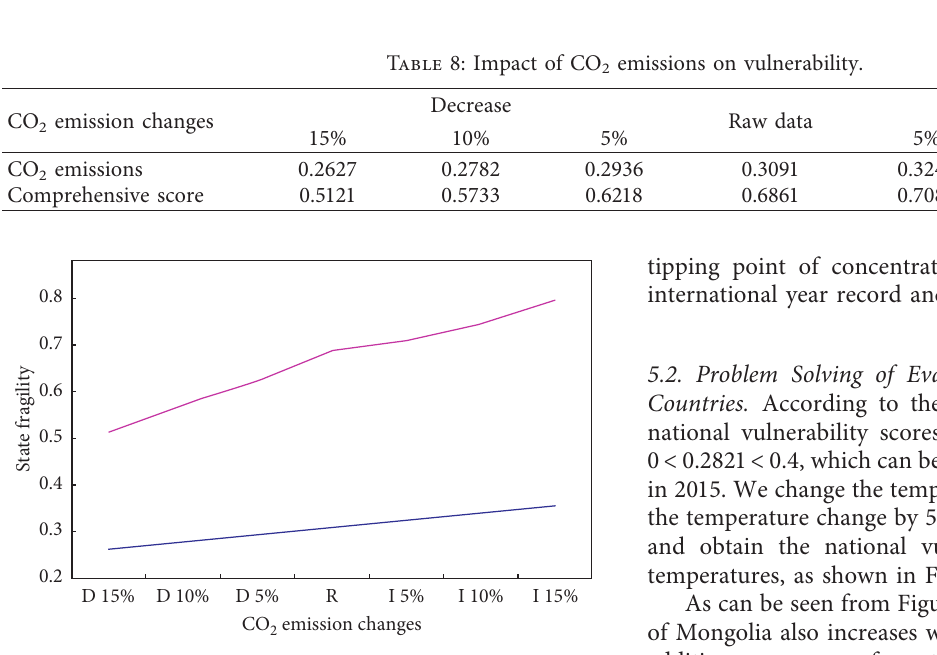
Figure 3: Impact of CO 2 emissions on state